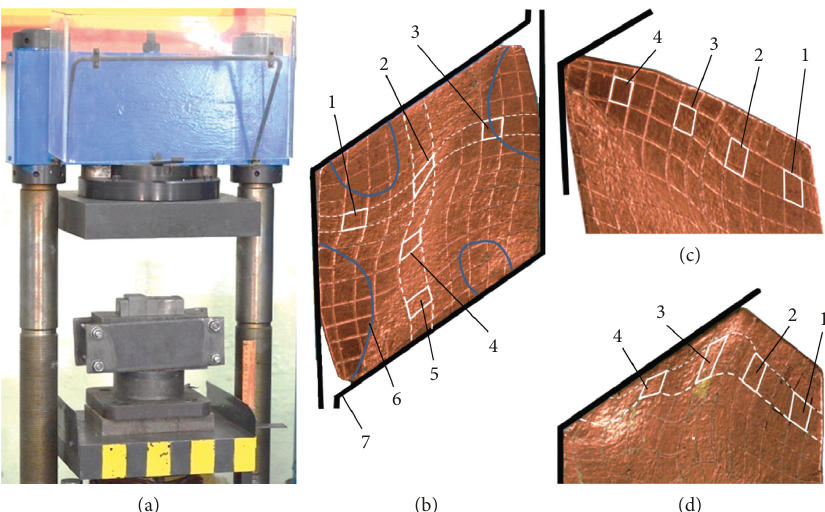
Figure 6: The results of experimental study of deformation of workpieces according to the RS-60 route. (a) Press and die for deforming of workpieces. (b) Position of the workpiece at the end of the 1st stage of deformation. (c) Initial position of the workpiece in the die. (d) Intermediate position of the workpiece at the 2nd stage of deformation.